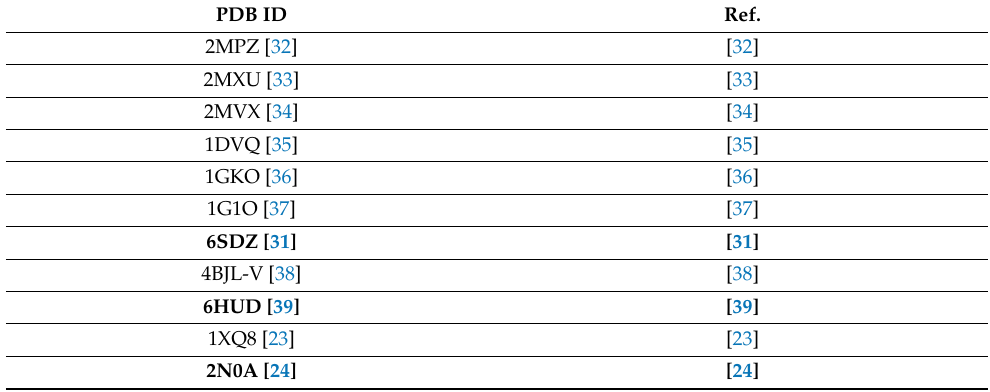
Table 2. The proteins analysed in the current work (amyloid forms in bold).